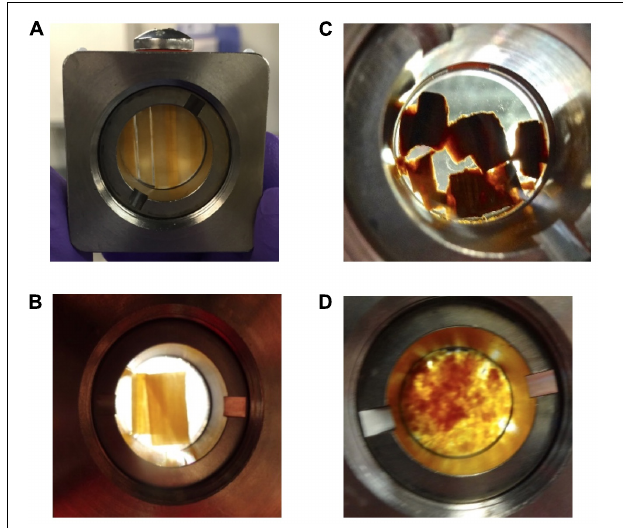
FIGURE 2 | D 2 O saturated samples loaded into titanium cells for SANS analysis showing the differences in sample alignment inside those cells. The majority of the (A) wood disks and (B) wood shavings were aligned vertically inside the titanium cells, whereas a few of the (C) delignified disks were less well oriented and the (D) decayed wood shavings were randomly